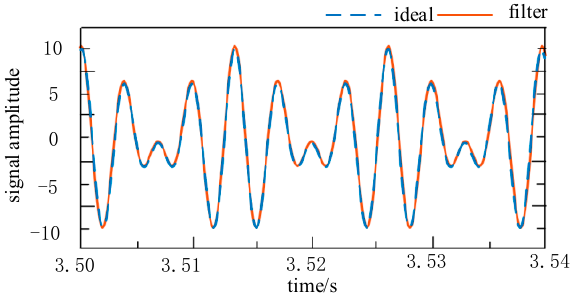
Figure 9. 300 Hz + 400 Hz undecomposed fi lter waveform and the original signal waveform comparison.